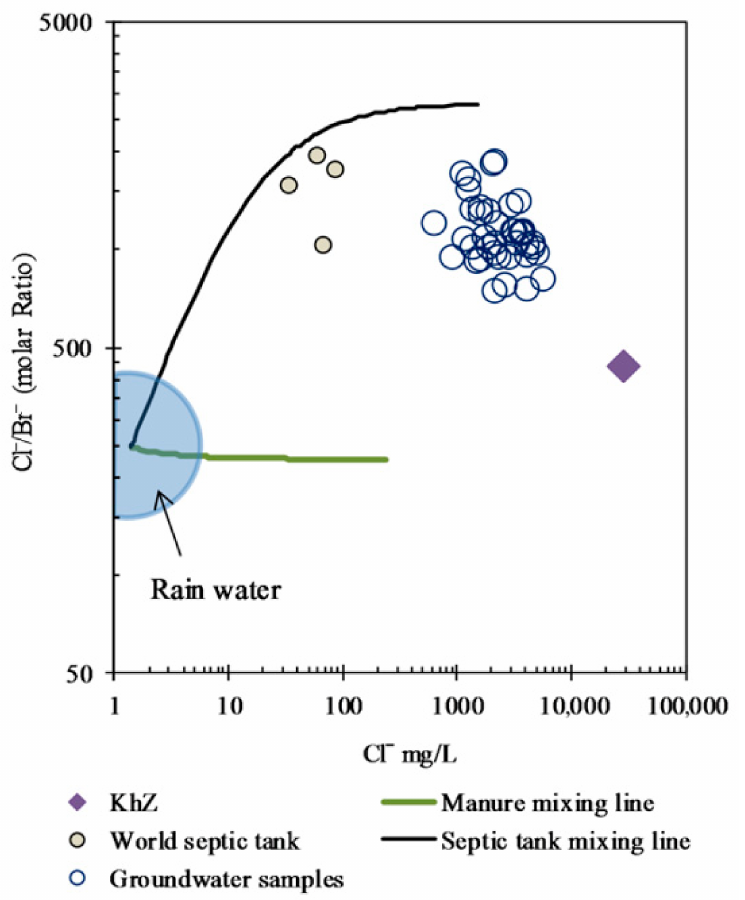
Figure 11. Relation of Cl − /Br − (molar ration) and Cl − (mg/L) concentration of groundwater samples in the AOI. Mixing lines according to data from McArthur et al. and Katz et al.